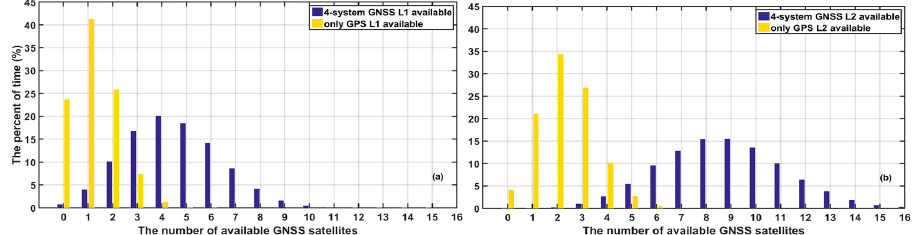
Figure 6. Percentage of time where the different GNSS satellite numbers are available in one epoch for a given GNSS-R LEO satellite at GPS L1 ( a ) and GPS L2 ( b ) frequency with peak gain.